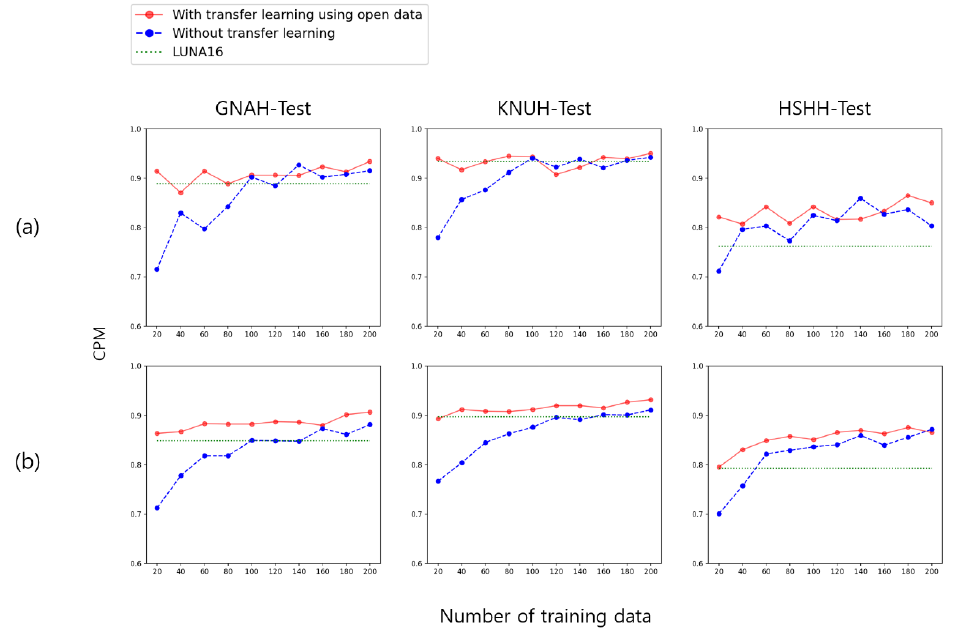
Figure 8. CPM results for models trained with incremental growth of GNAH and KNUH combined data. ( a ) YOLOX; ( b ) EfficientDet.